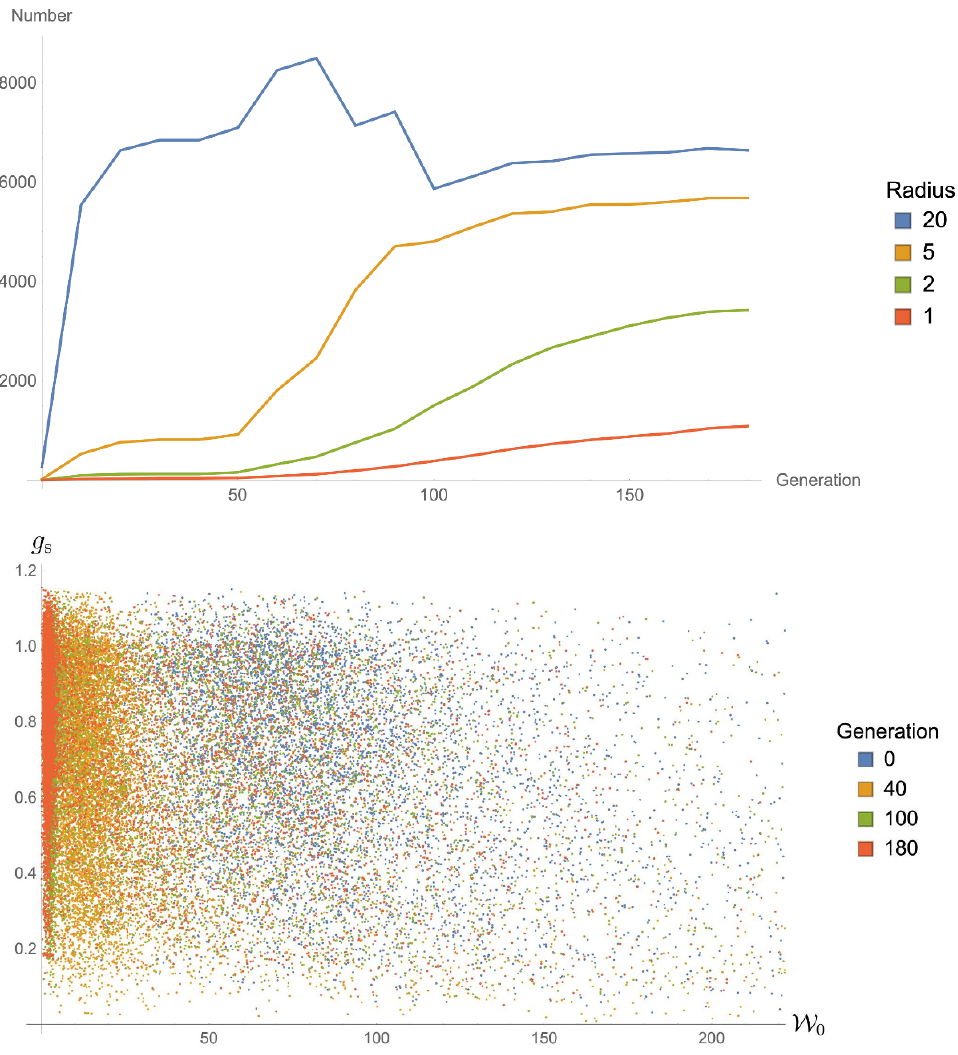
Figure 14 . Top: the number of members in neighborhoods of di(cid:11)erent radius around W (cid:3) the evolution of the distribution of g s and W 0 for four